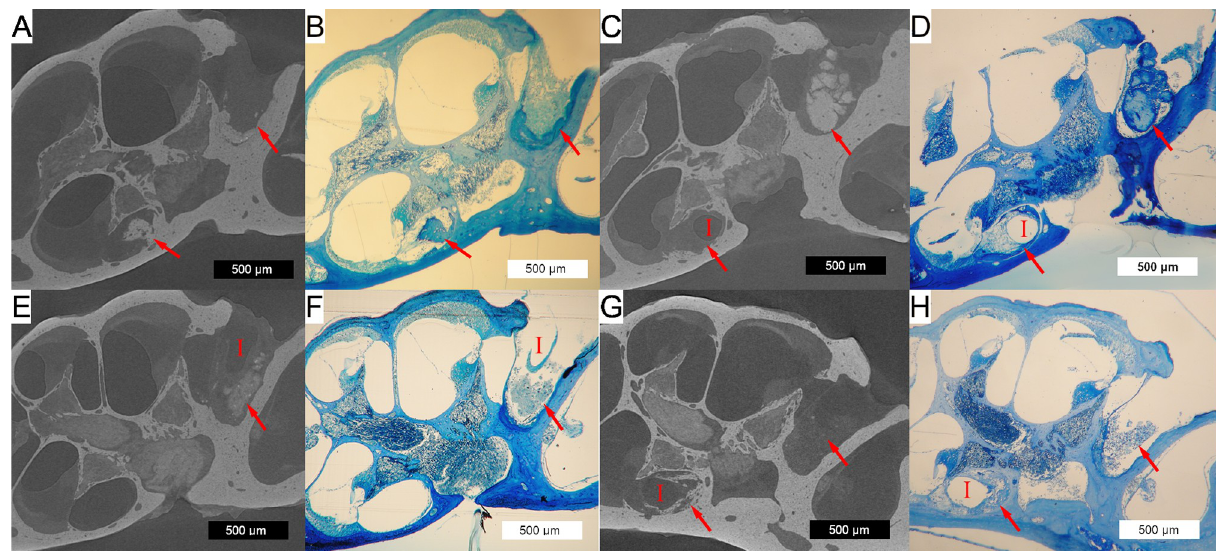
Fig 9. 3D x-ray microscopy and histologic co-localization. 3D x-ray microscopic images (A,C,E&G) are co-localized next to corresponding histologic sections (B,D,F and H) for non-stimulated (A-D) and stimulated (E-H) subjects. The implant tract (marked by a red “I”, where visible) with adjacent soft tissue and neo-osteogenesis is seen in the round window and basal turn of the scala tympani. Representative 500 μ m scale bars are provided for each image. Red arrows mark the tissue response within the scala tympani and round window area.